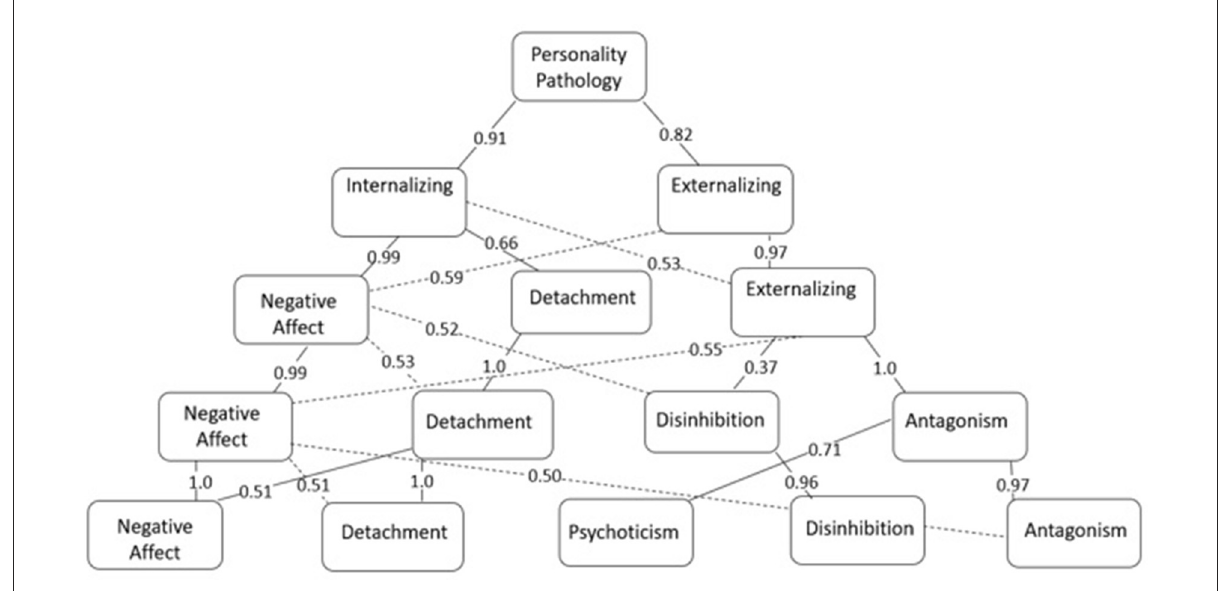
FIGURE1 PID-5 (paper-and-pencil) five-level hierarchical structure ( N = 730)—Path Coefficients between subordinate and superordinate